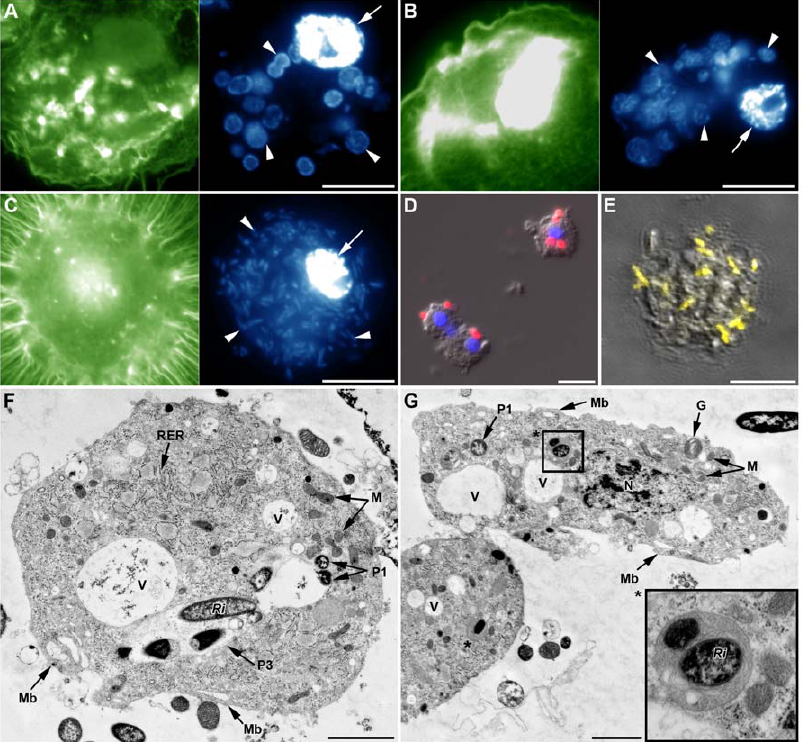
Figure 9. Invivo phagocytosis of primary symbionts and injected secondary symbionts in LL01 and YR2-Amp aphids (devoid of SS). (A–B) Fluorescent images of AHP from LL01 (A) and YR2-Amp (B) unchallenged lines. Hemocytes have taken up B. aphidicola ( Ba ) cells (arrowheads); F-actin in green, DNA in blue, arrows indicate cell nuclei. (C) Fluorescent images of AHP from the LL01 line, 24 h after injection of R. insecticola ( Ri ) secondary symbionts. Ri are observed in the cytoplasm of a granulocyte (arrowhead); F-actin in green, DNA in blue, arrows indicate cell nuclei. (D) Overlay of DIC and fluorescent images from AHP of unchallenged LL01 aphids, showing FISH detection of Ba cells (red fluorescence) in contact or within adherent hemocytes. Nuclei are counterstained with DAPI (blue fluorescence). (E) Overlay of DIC and confocal images showing FISH detection of Ri secondary symbionts (yellow fluorescence, false color) in a granulocyte of an LL01 aphid, 24 h post-injection. (F–G) TEM showing secondary symbionts Ri within LL01 hemocytes 24 h post-injection. Notice the high vacuolization ( V : Vacuoles), the presence of membrane ruffles ( Mb ) and the phagosomes containing ingested Ri . (F) LL01 Plasmatocyte showing two zipper-like phagosomes containing individual bacteria ( P1 ) and a macropinocytosis-like phagosome ( P3 ) containing several symbionts, some in advanced state of degradation (high darkening). (G) LL01 granulocytes showing zipper-like phagosome ( P1 ) and phagolysosomes containing symbionts (asterisk and box magnified). Scale bar: 10 m m (A–E), 1 m m (F) and 2 m m (G). N : Nucleus; M : Mitochondria; RER : Rough endoplasmic reticulum; G :